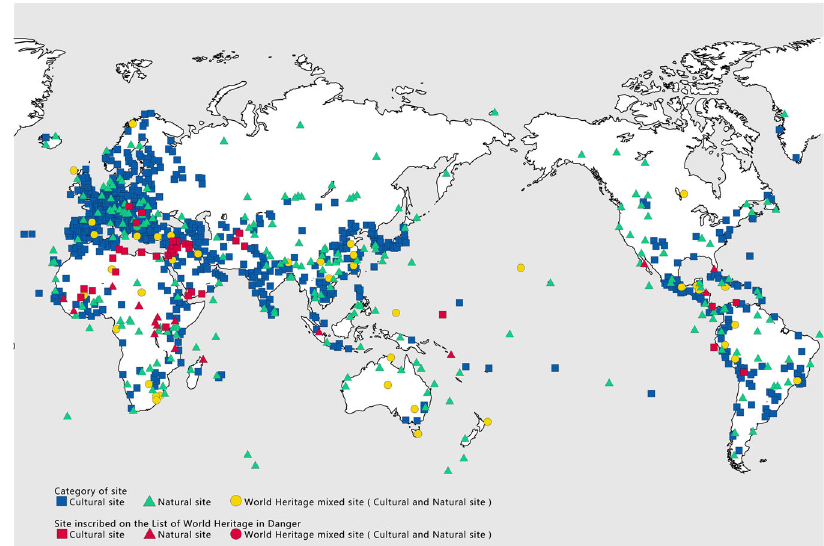
Fig. 20 The map of World Heritage